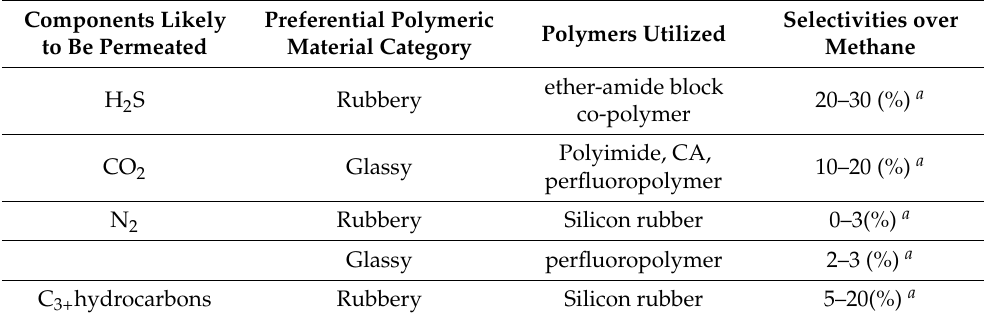
Table 2. Commercial membrane materials as well as their selectivities for impurity removal from